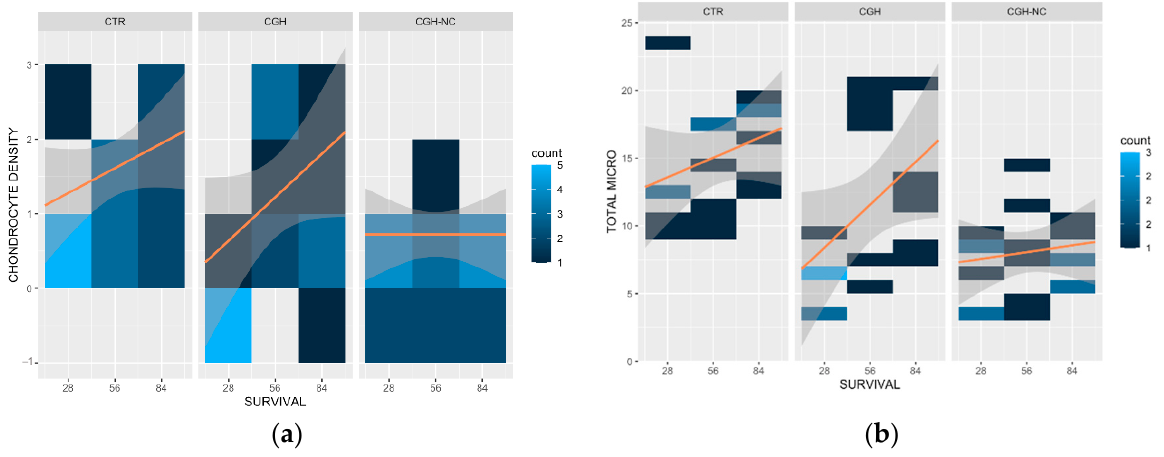
Figure 4. Heat maps representing “chondrocyte density” ( a ) and “total microscopic score” ( b ) for the different treatment groups and survival times and the frequency of occurrence at different survival times. Clearer colours result in an increase of the frequency of each stage of the disease. Orange lines are included on the maps to facilitate the understanding of the behavior of each treatment and the survival time. “Chondrocyte density” shows how CGH-NC lead to less degenerative changes when evaluated together with survival time ( p < 0.1). “Total microscopic score” showed a statistically significant ( p < 0.05) change with survival time regardless of the treatment.